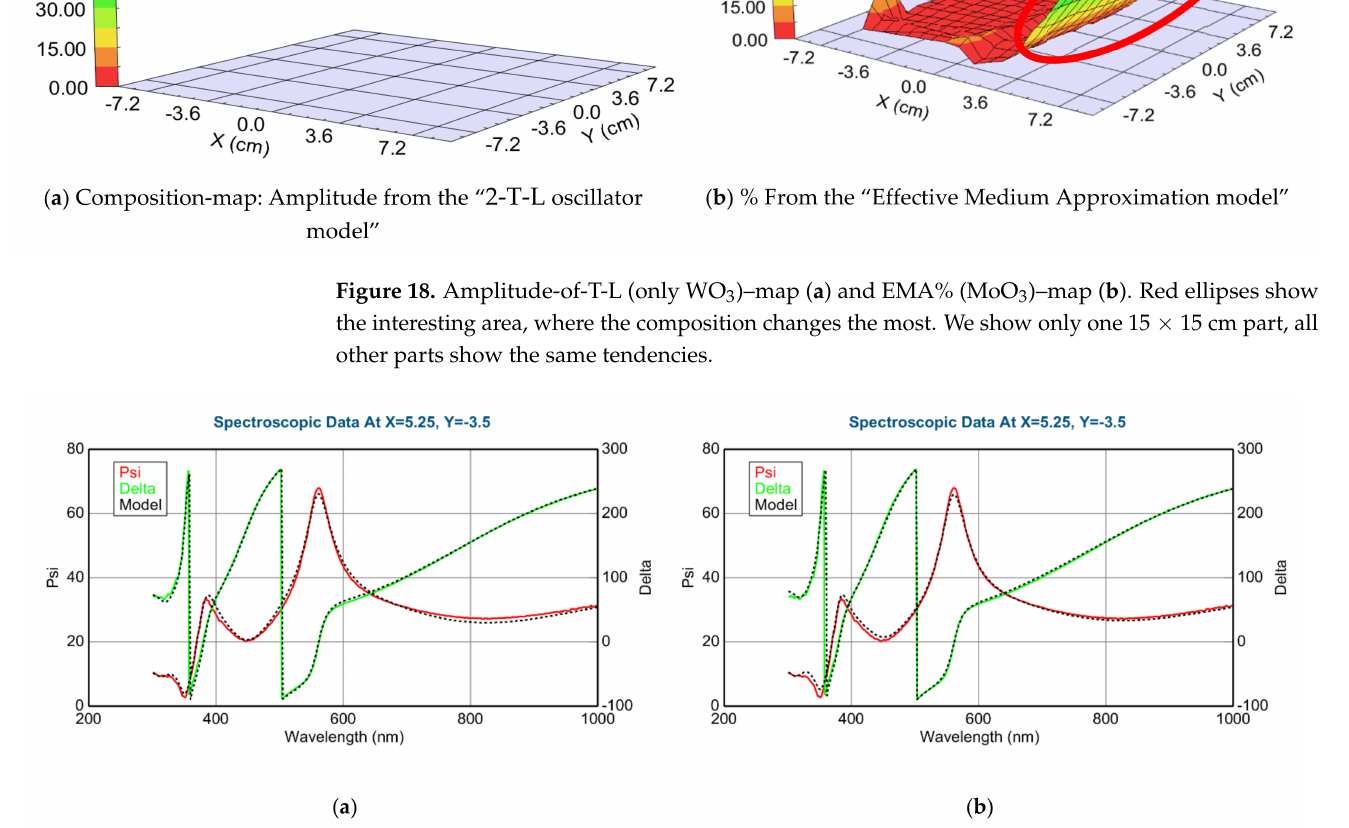
Figure 19. Measured and fitted spectra at one sample point: 2-Tauc-Lorentz (2-T-L) oscillator model. ( a ) Fit error (MSE) = 29.2, Thickness = 230.4 ± 0.8 nm, Amp1 = 58.0 ± 1.5, Amp2 = 11.4 ± 0.7, and Effective Medium Approximation model; ( b ) fit error (MSE) = 24.8, Thickness = 218.0 ± 0.1 nm, EMA% (Mat2) = 28.5 ±